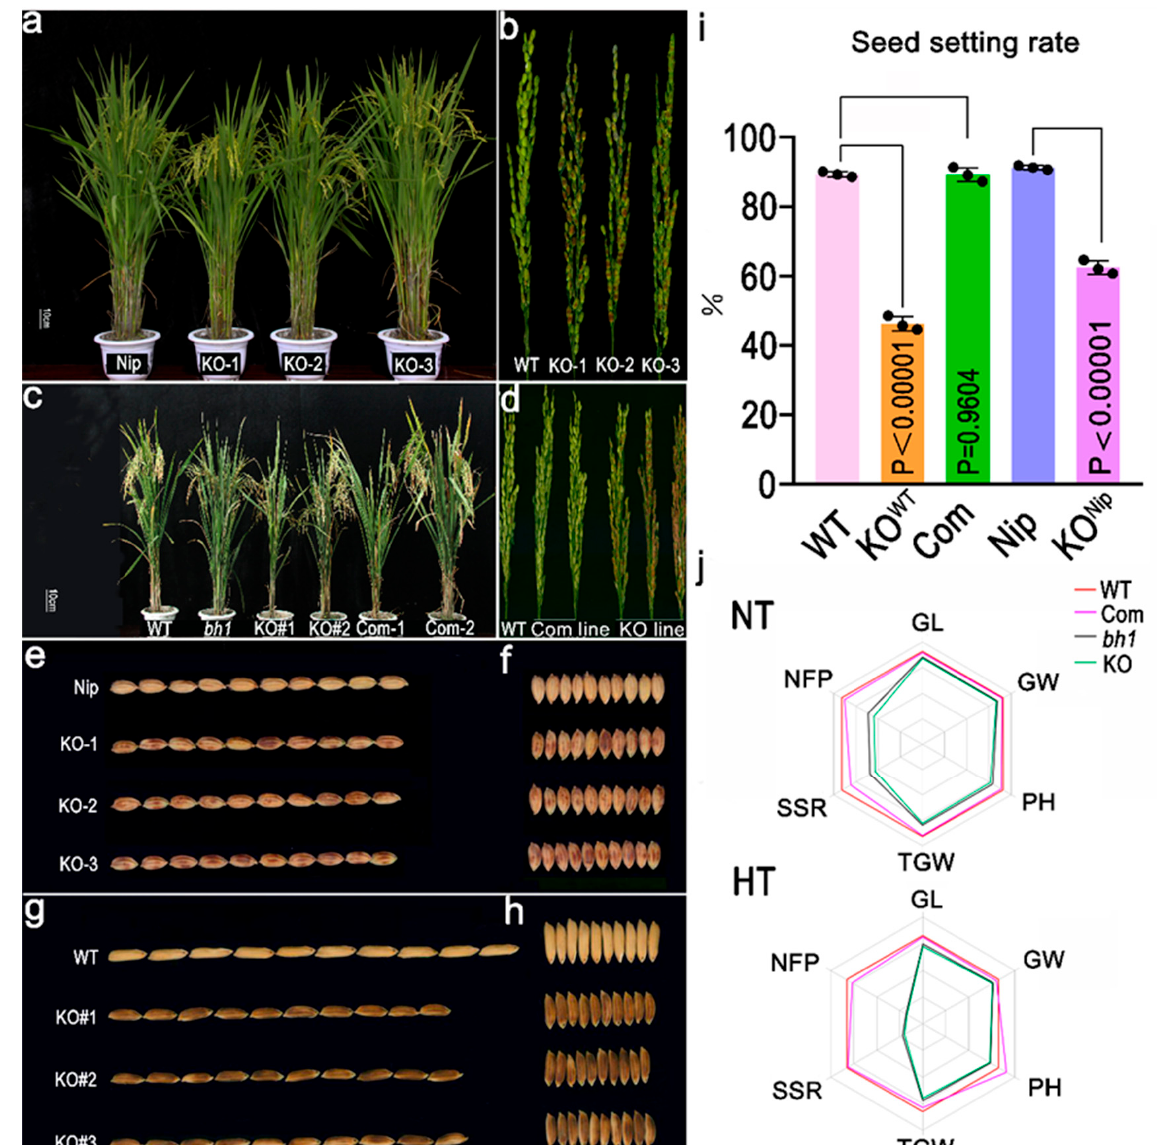
Figure 5. Transgenic assays of complementation and knockout to validate the function of Β -gluco- sidase (Os1 β Glu4). ( a ) Plant morphology, ( b ) panicle morphology of Nipponbare (Nip), KO Nip -1, KO-2 Nip , KO-3 Nip ( c ) plant morphology of ( d ) panicle morphology of WT, bh1 , KO WT #1, KO WT #2, complementation line-1, complementation line-2 (left to right, respectively), ( e ) image showing grain length, ( f ) grain width of Nip, KO Nip -1, KO-2 Nip , KO-3 Nip (from top to bottom), ( g ) image showing grain length, ( h ) grain width of WT, KO WT #1, KO WT #2, KO WT #3 (from top to bottom), ( i ) Graph showing the comparison of seed setting rate of WT, KO WT , Complementation, Nip, KO Nip , ( j ) Com- parison of agronomic traits of WT, Complementation, bh1 , KO line, where NT: Normal temperature (top), HT: High temperature (bottom), GL: Grain length, GW: Grain width, PH: Plant height, TGW: Thousand-grain weight, SSR: Seed setting rate, NFP: Number of filled grains per panicle.